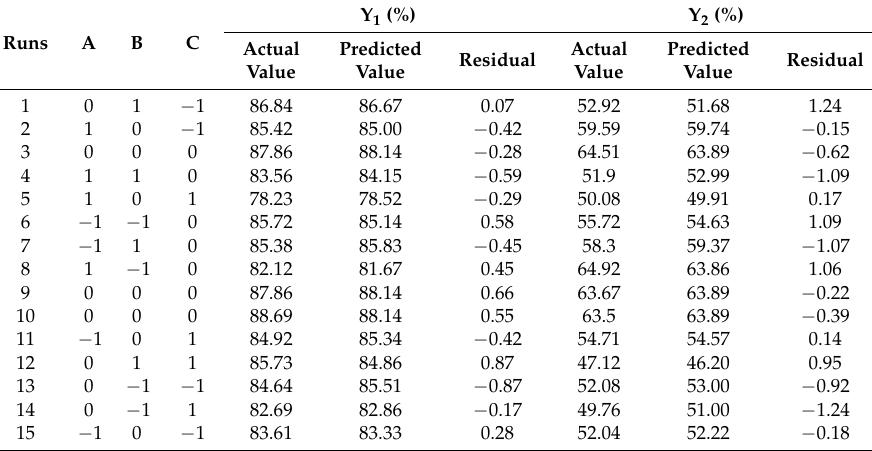
Table 5. B–B experimental design and results for nutrients promoting peptide production. A, calcium lactate; B, glucose; C, casein peptone.